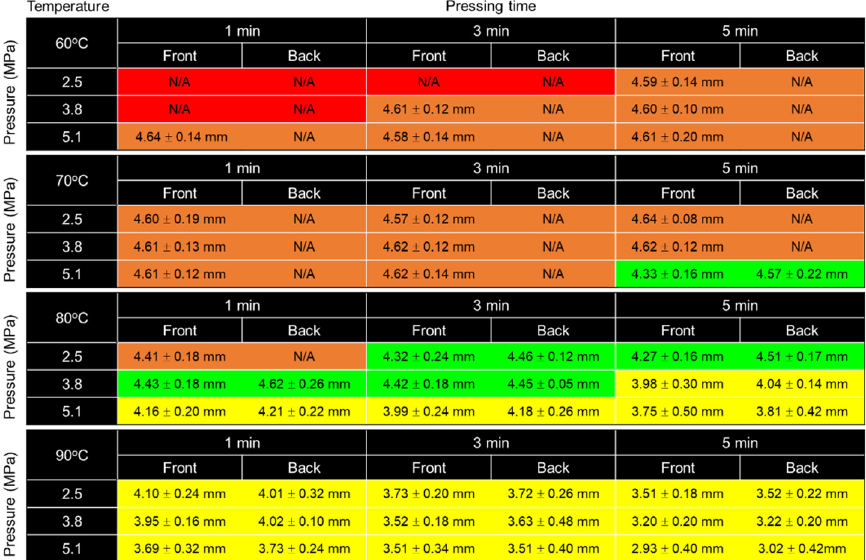
Figure 6. The colour-coded evaluation matrix of fabrication parameters and the diameter size of circular hydrophilic area after the fabrication. N/A denotes that actual circular size of diameter cannot be measured due to incomplete parafilm permeation. At least 3 samples were measured. Colour codes: red—no parafilm on both sides, orange—parafilm has not fully permeated, green—parafilm can be seen on both sides, and yellow—over-penetration.